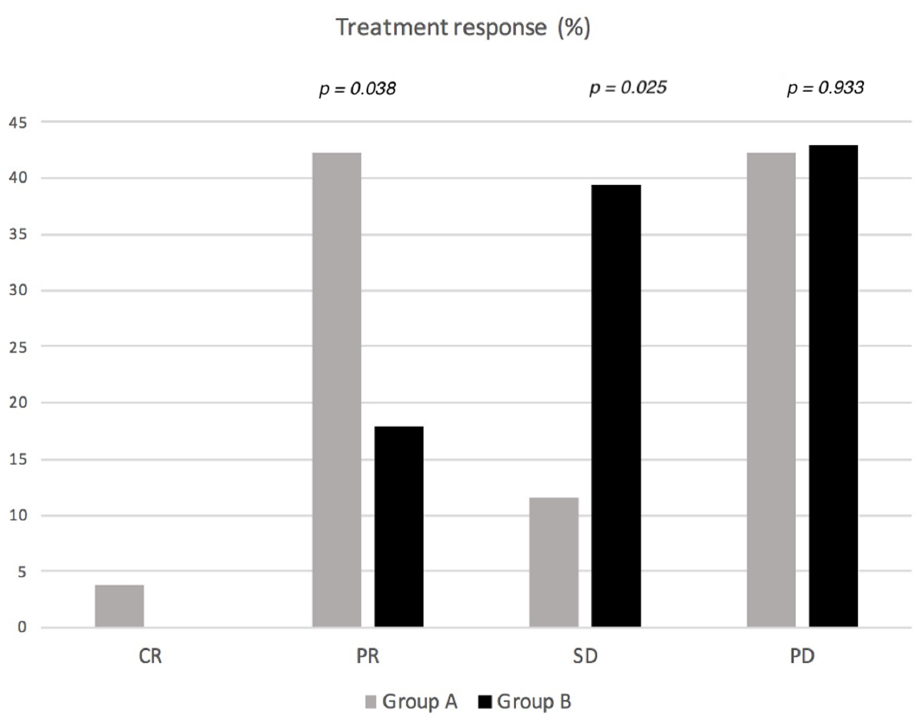
Figure 2. Comparison of treatment response between the two groups using chi-squared tests. Signifi- cance level was taken as p < 0.05.